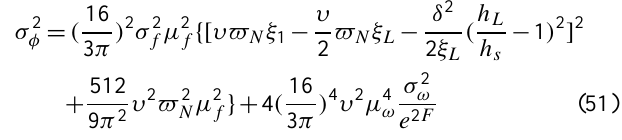
Fig. 2. Dimensionless variance of seawater-freshwater interface el- evation as a function of dimensionless position for various values of µ f